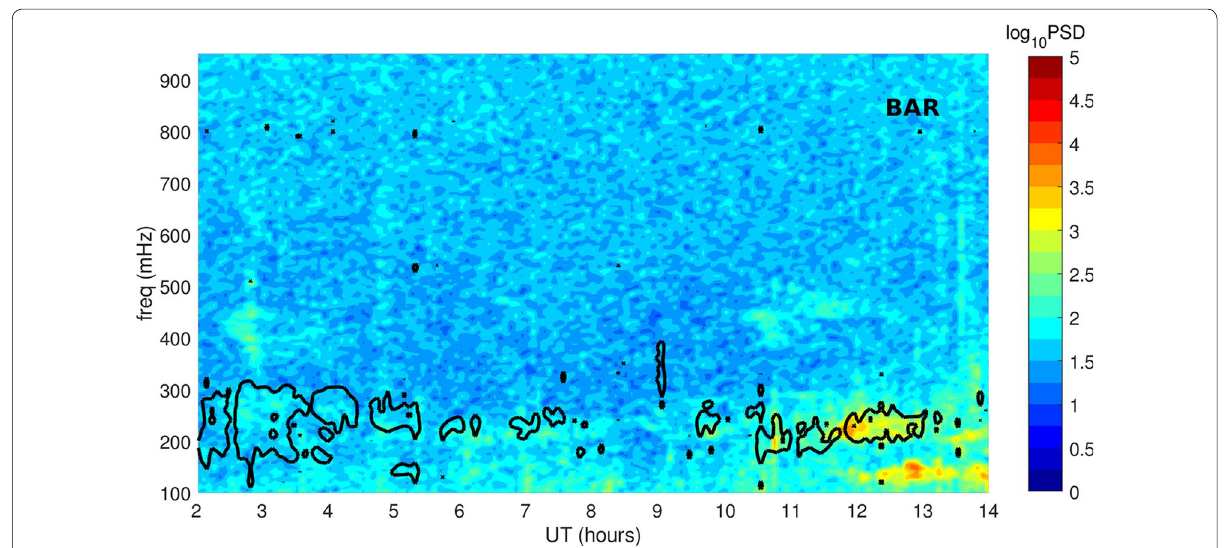
Fig. 7 The dynamical spectrum of Pc1 pulsations at BAR (L